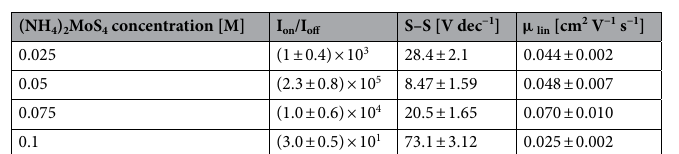
Table 1. Analytical results for electrical properties of transferred MoS 2 TFTs with the concentration of precursor solution.